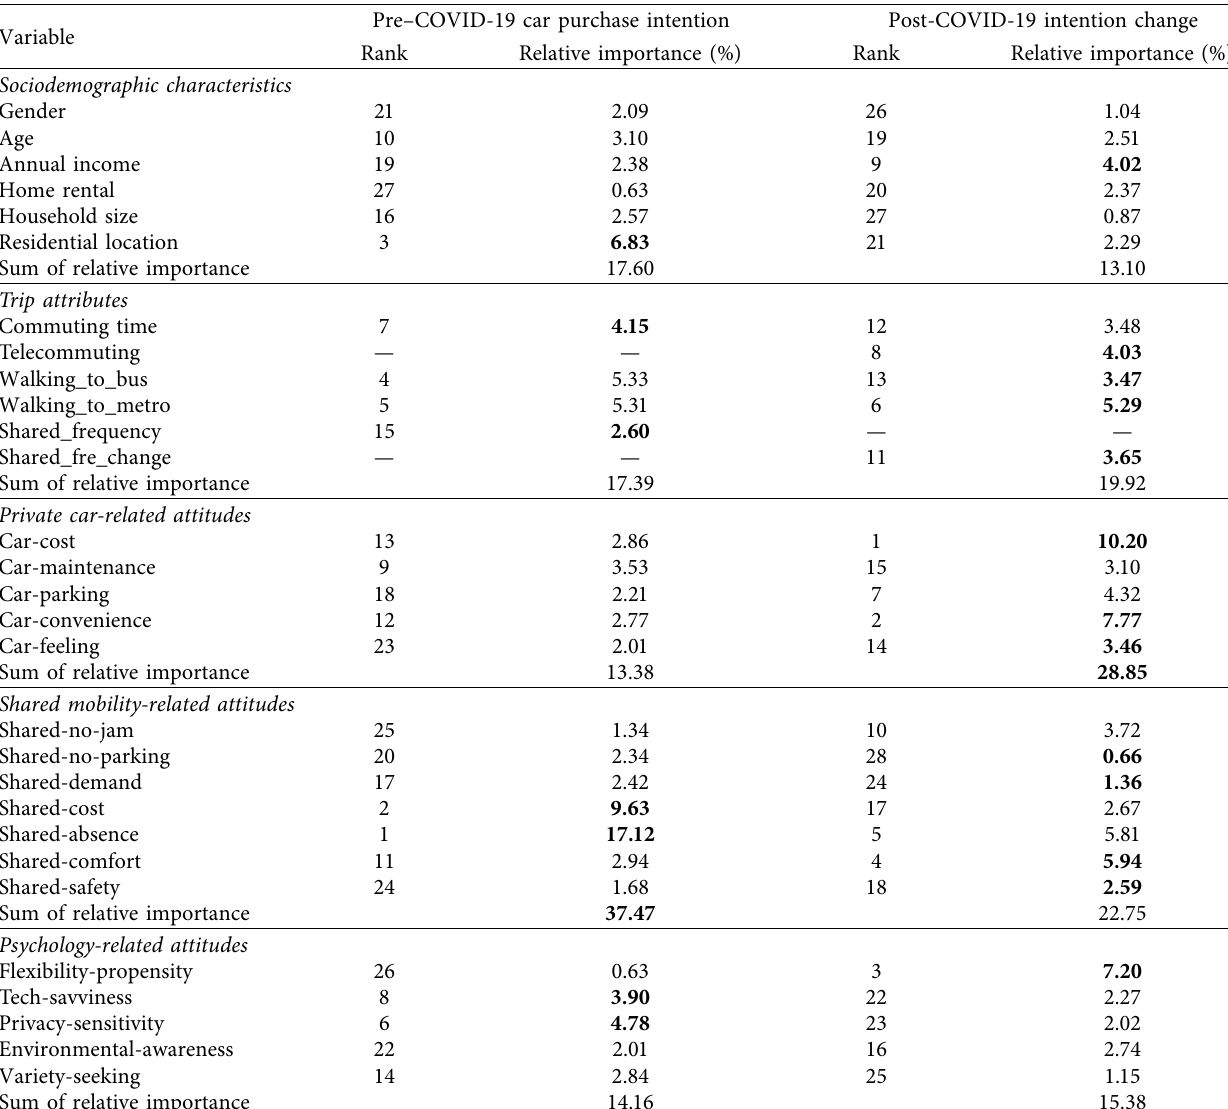
Table 4: The relative importance of influencing factors to the pre–COVID-19 car purchase intention and the post–COVID-19 intention